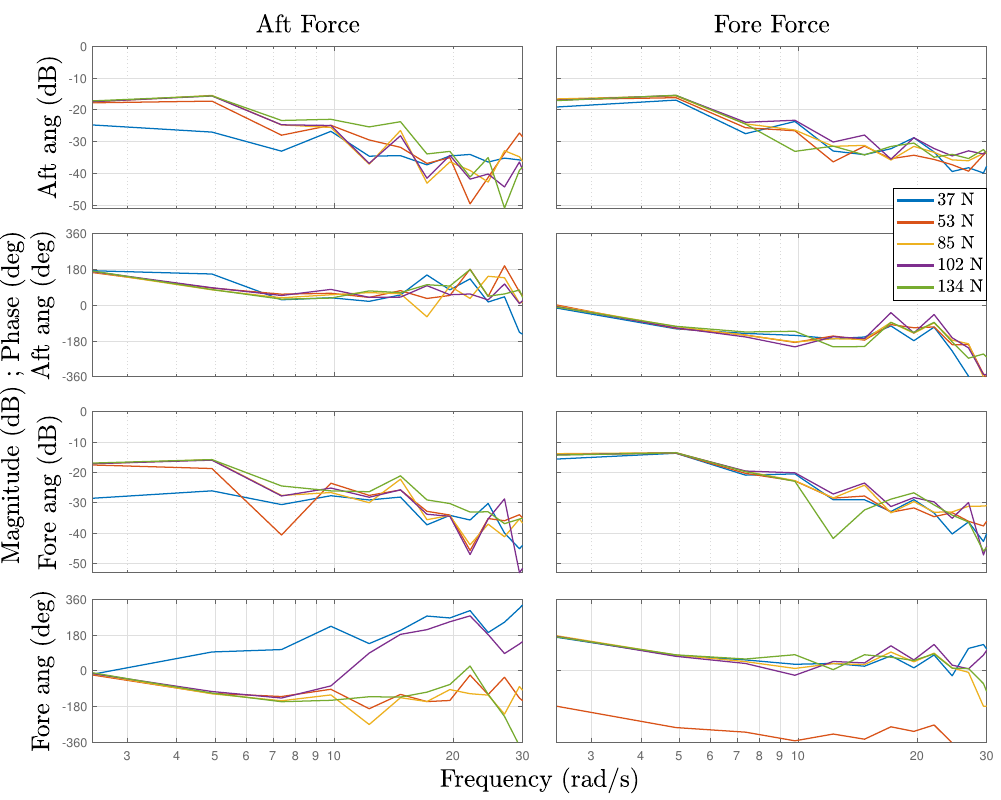
Figure 7. Empirical transfer function